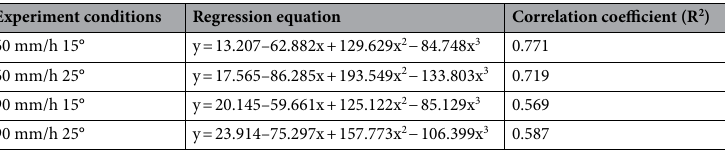
Table 4. Significant correlation and regression analysis between application rate (x) and average runoff rate.